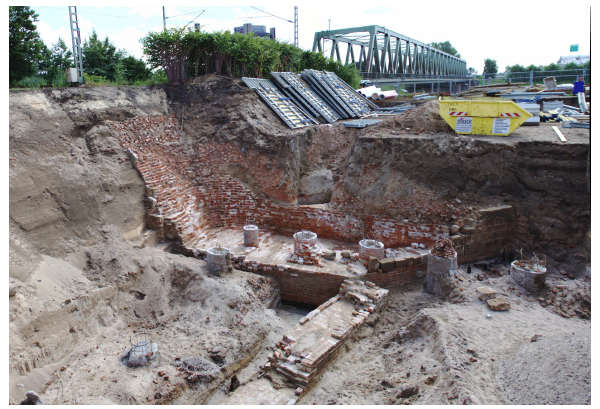
Figure 5. Excavation of the rediscovered Stephanitorzwinger in Bremen, Germany. Table 1. Exposure value corrections applied to images for radio- metrical alignment for the data set